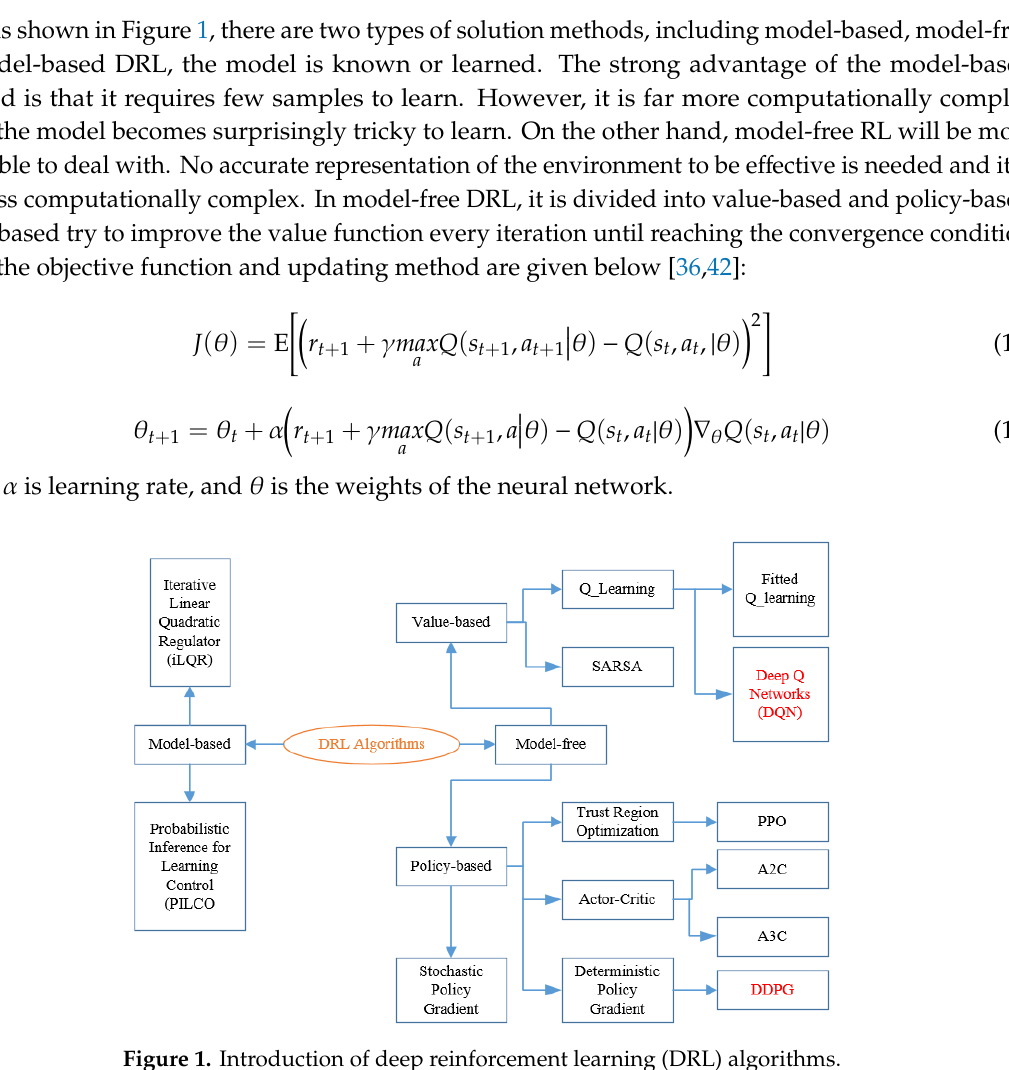
Figure 1. Introduction of deep reinforcement learning (DRL) algorithms.